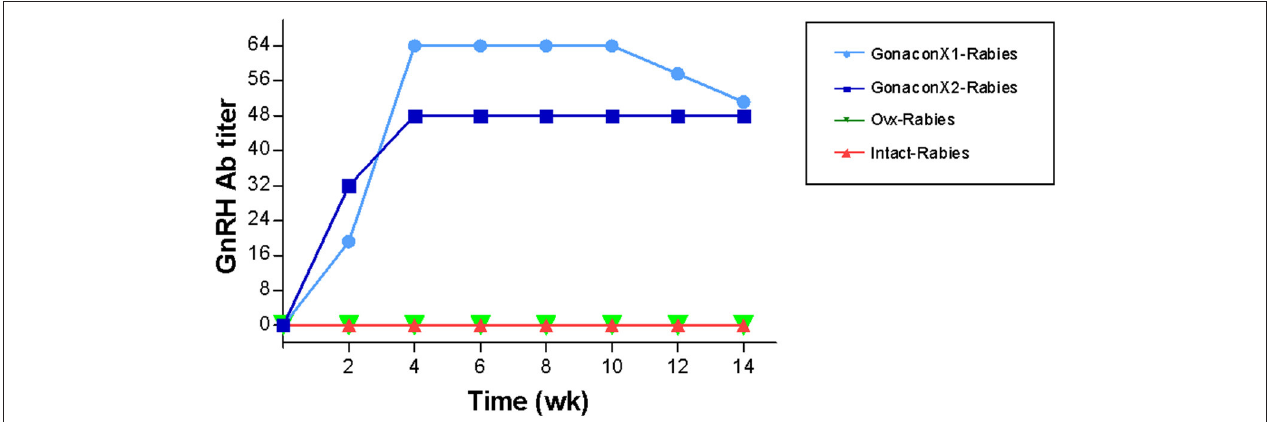
FIGURE 5 | Serum GnRH antibodies titer of cats in the research groups. Mean ± SEM GnRH titers are presented for each group: GonaconX1-Rabies: cats vaccinated with both Gonacon and rabies ( n = 5); GonaconX2-Rabies: cats vaccinated twice with Gonacon (3 weeks apart) and with rabies ( n = 4); OVx-Rabies: cats ovariohysterectomized and vaccinated with rabies ( n = 4); Intact-Rabies: cats vaccinated against rabies and remained intact ( n = 3). Blood samples were collected every 2 weeks for a total of 14 weeks. There were significant effects of the group, the time, and the group X time interaction on the anti-GnRH antibodies titer (Repeated measure ANOVA, p ≤ 0.0003). Variability within each group was extremely small, and therefore the SEM are